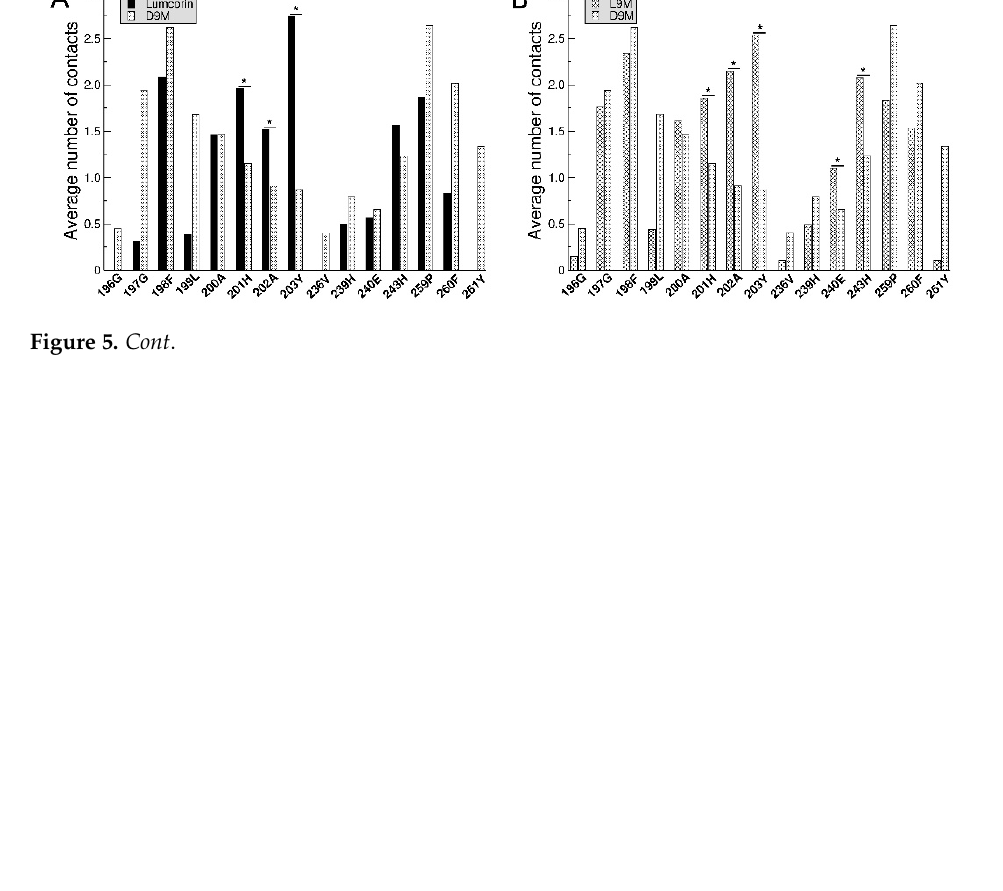
Figure 5. Pairwise comparison of the number of contacts between MMP-14 and different SLRP-de- rived peptides. The average numbers of contacts (hydrophobic or through hydrogen bonds) and their root mean square deviations computed over the 100 dockings were evaluated for each residue of the MMP-14 catalytic region. Panels ( A ) to ( D ) correspond to the training set of the protocol since inhibitory peptides (lumcorin and L9M) are compared to inactive peptides (D9M and F9M); panels A, B, C, and D display the comparison of lumcorin and D9M, L9M and D9M, lumcorin and F9M and L9M, and F9M, respectively. In the case of D9M and F9M, for which there is more than one representative structure (5 for D9M and 2 for F9M) extracted by the clustering analysis, all the con- formations were compared to the representative structure of lumcorin and L9M. For clarity pur- poses, only the comparisons with the first cluster are presented. Panels E and F display the compar- ison of L9Mc with lumcorin and L9M, respectively. Error bars (root mean square deviations) are not represented on the different panels but were taken into account for the comparison of the number